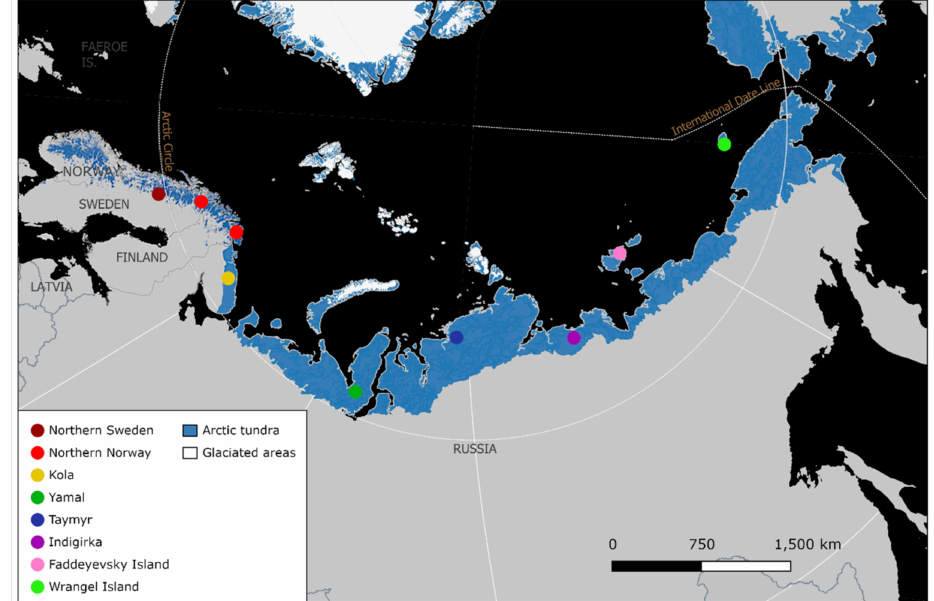
Figure 1. Map showing the distribution of Arctic tundra habitat (Scandinavia: alpine tundra [60]; Eurasia: oro-arctic tundra [61]) in relation to study sample areas in northern Sweden, northern Norway, Kola, Yamal, Taymyr, Indigirka, Faddeyevsky Island and Wrangel